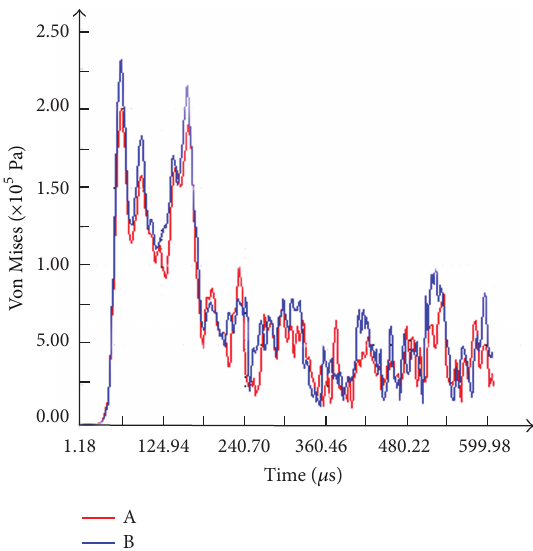
Figure 18: Time-dependent stress of A, B point in drop test (model with flute angle 𝜃 of 40 ∘ ).